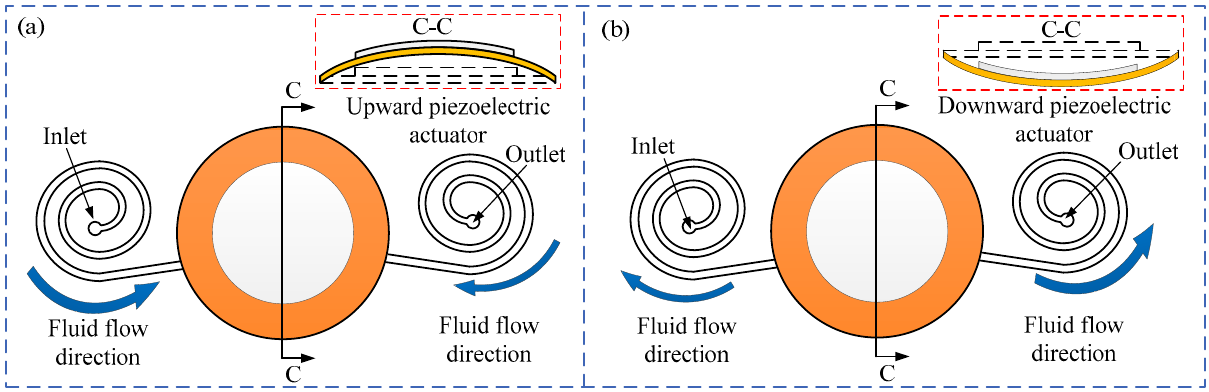
Figure 4. The working processes of valveless piezoelectric pumps with spiral tubes. ( a ) Suction process. ( b ) Discharge process.